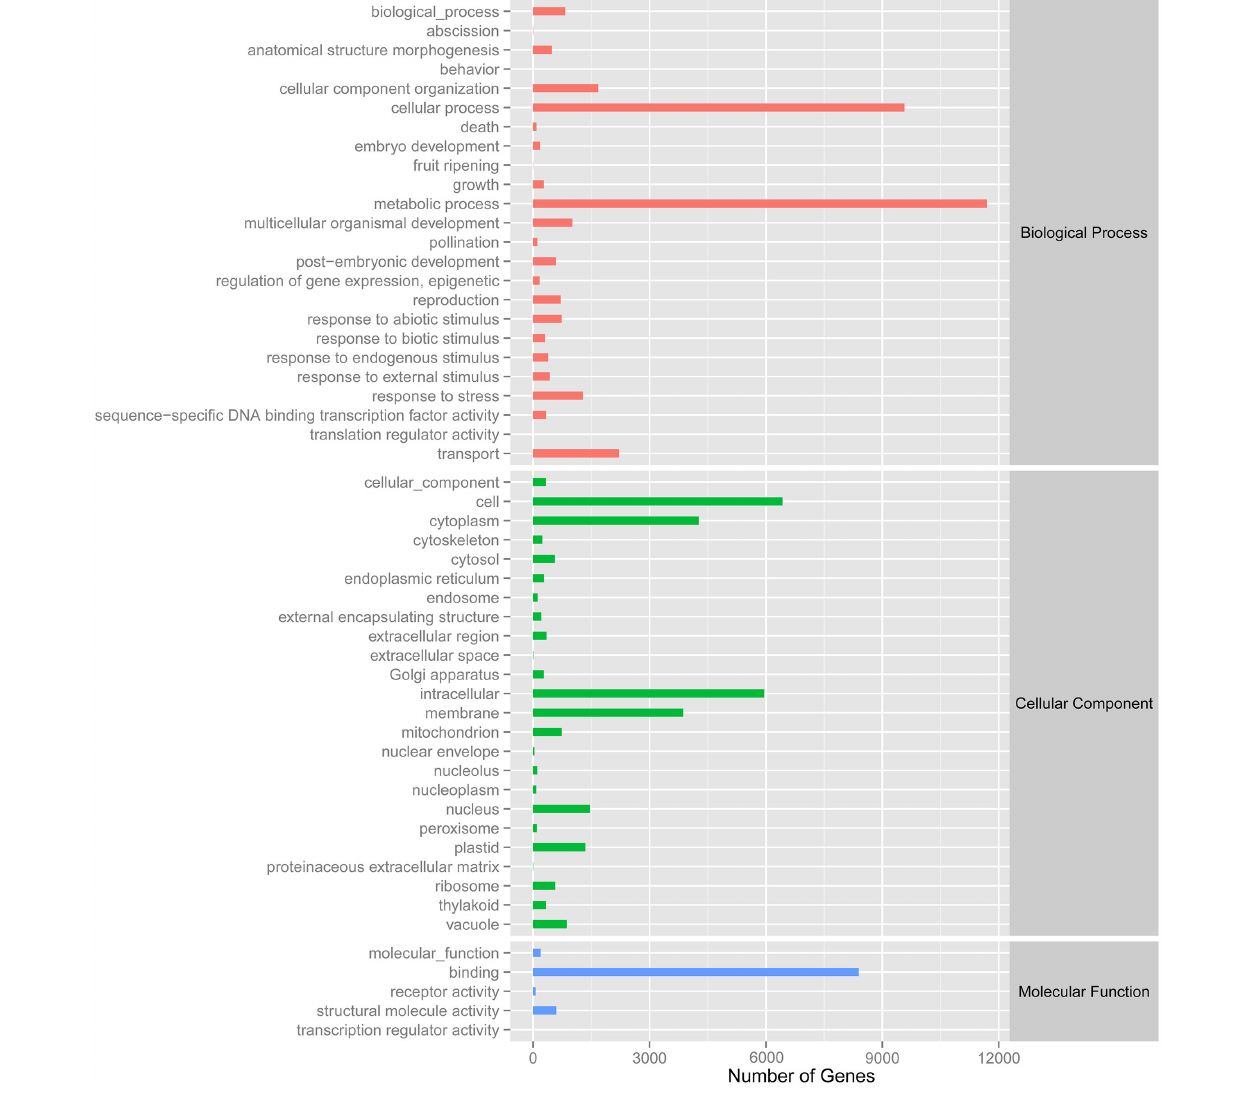
Frontiers in Plant Science |